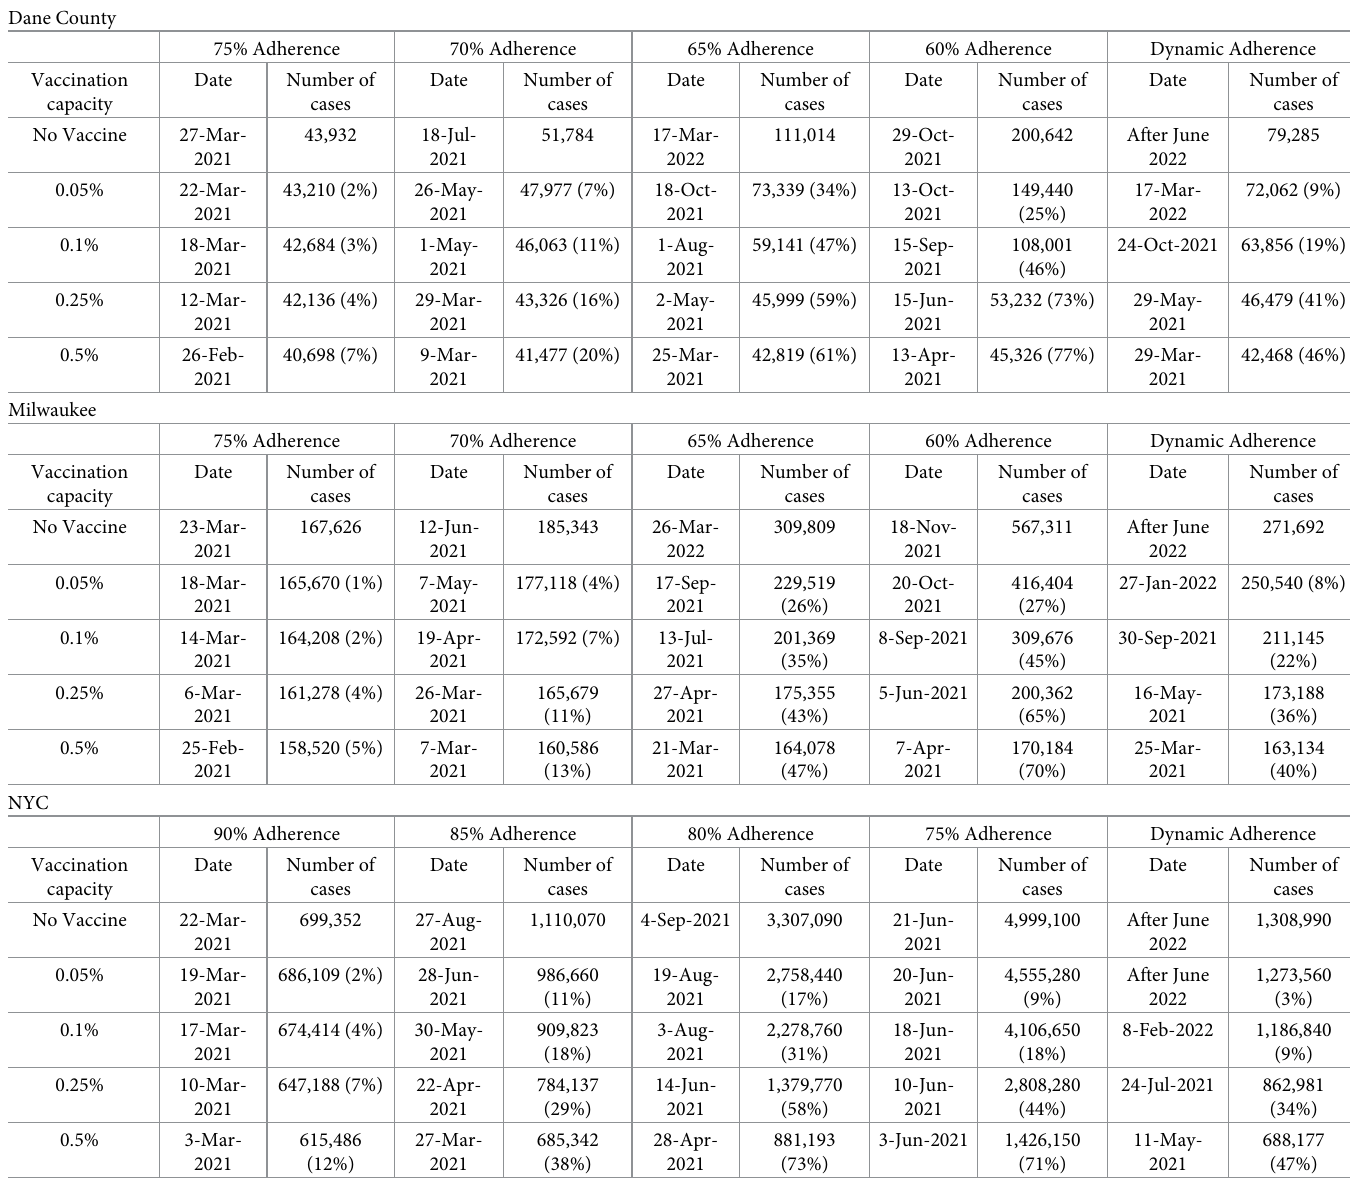
Table 2. Controllable spread date and number of cases on December 31, 2021 for different daily vaccination capacity and adherence to nonpharmaceutical inter- ventions (NPI) scenarios (vaccine effectiveness 90%, vaccine coverage 50%). Dane County 75%